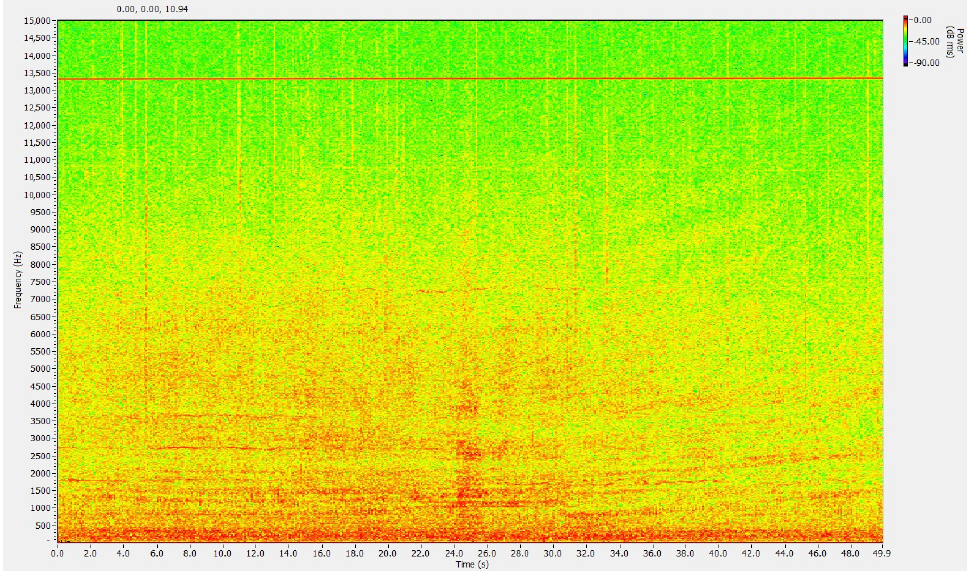
Figure 14. Signal energy chromatogram at substation 1.